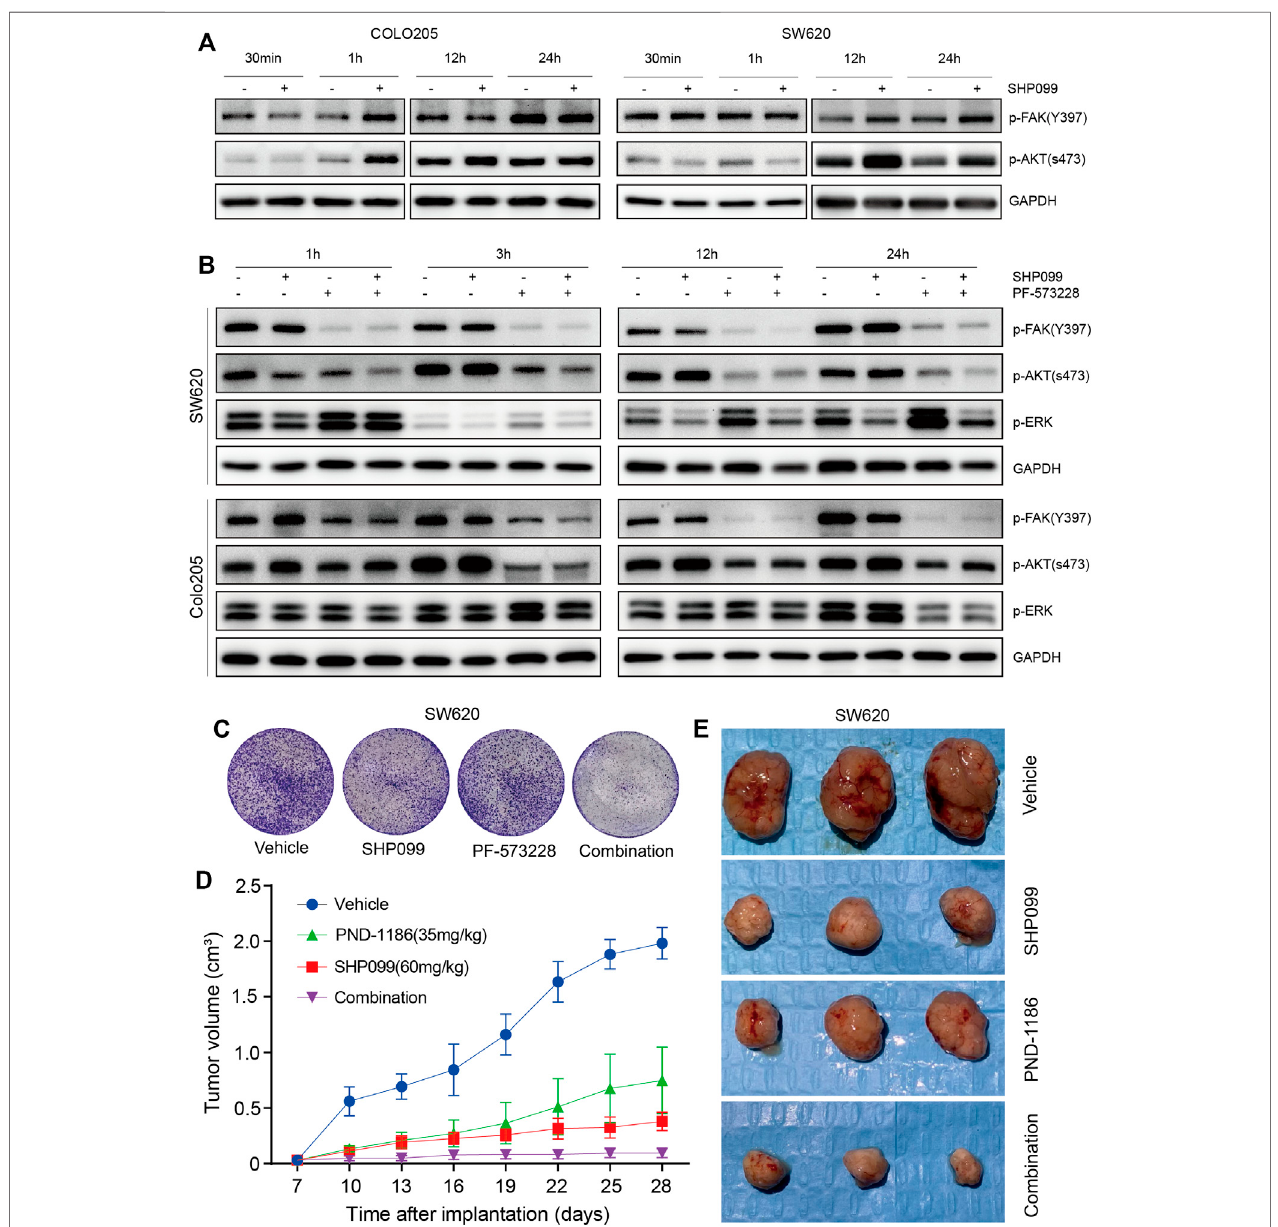
FIGURE 6 | p-FAK inhibition improves antitumor ef fi cacy when combined with SHP099. (A) Dynamic p-FAK is associated with the feedback activation of AKT signaling. (B) DynamiceffectofSHP099andPF-573228(10 μ M)ontheAKTandERKsignalinginCRCcells. (C) PF-573228sensitizesthecolonyinhibitionofSHP099in SW620cells. (D) PND-1186enhancesthegrowthinhibitionofSW620xenograftsbySHP099. (E) ImagesofisolatedtumorsfromSW620xenograftstreatedbySHP099 and/or PND-1186.